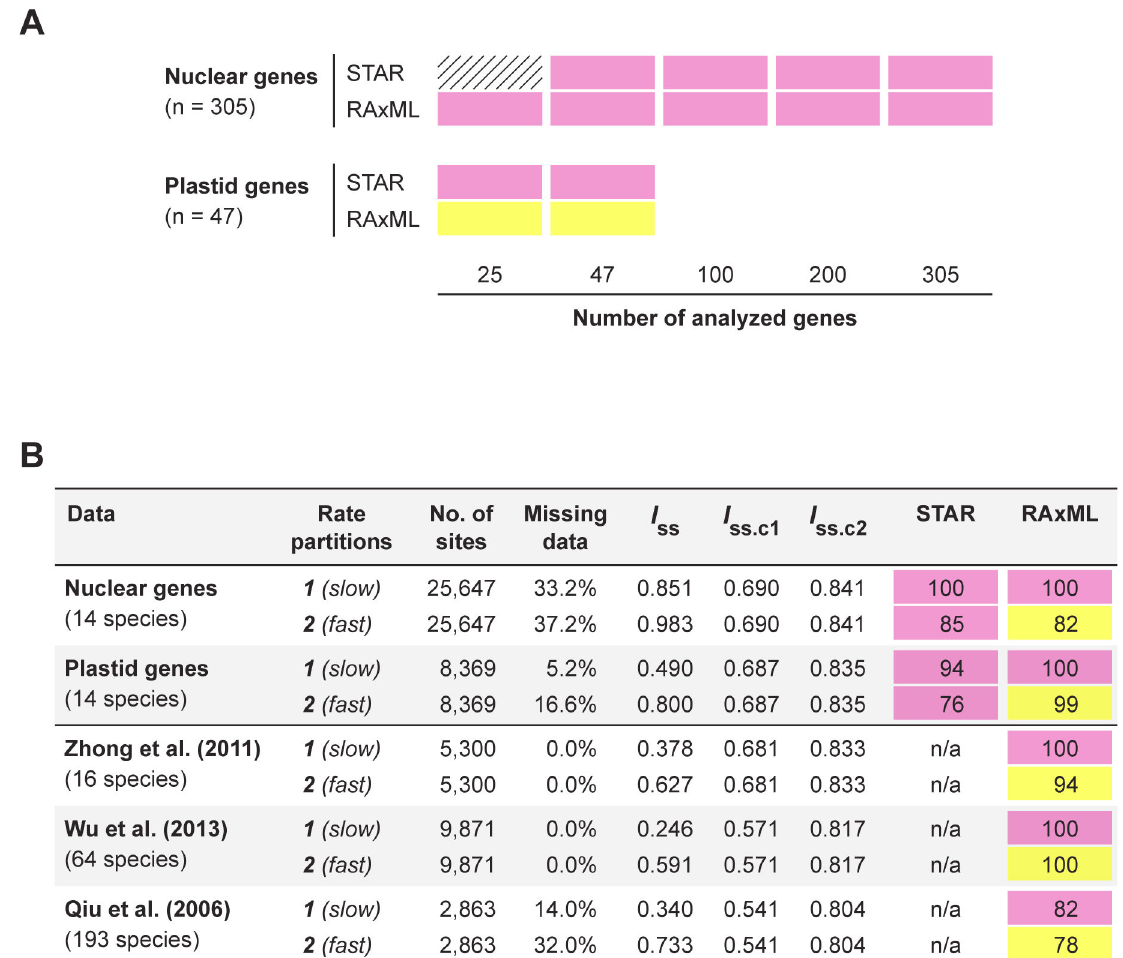
Figure 3. Summary of bootstrap percentages (BPs) from coalescent and concatenation analyses using different gene subsampling and rate partitions. (A) BPs from coalescent and concatenation analyses using different gene subsampling. The 305 nuclear genes were subsampled for four different gene size categories (i.e., 25, 47, 100, or 200 genes; 10 replicates each), and the 47 plastid genes were subsampled for 25 genes (10 replicates). Cells with hatching indicate that support for the placement of Ginkgo biloba from all replicates is below 80 BP; colored cells indicate relationships that received bootstrap support ≥80 BP from at least one replicate (pink = cycads plus Ginkgo as sister to all remaining extant gymnosperms, yellow = Ginkgo alone as sister to conifers and gnetophytes within extant gymnosperms; see also Figure 1D). (B) BPs from coalescent and concatenation analyses across different nucleotide rate partitions. Parsimony informative sites in concatenated matrices were sorted based on estimated evolutionary rates, and subsequently divided into two equal partitions. The index of substitution saturation ( I nucleotide substitution saturation for sites within each rate partition. The two critical I using an asymmetrical and symmetrical topology, respectively (for data including more than 32 species, only values estimated from 32 terminals are shown